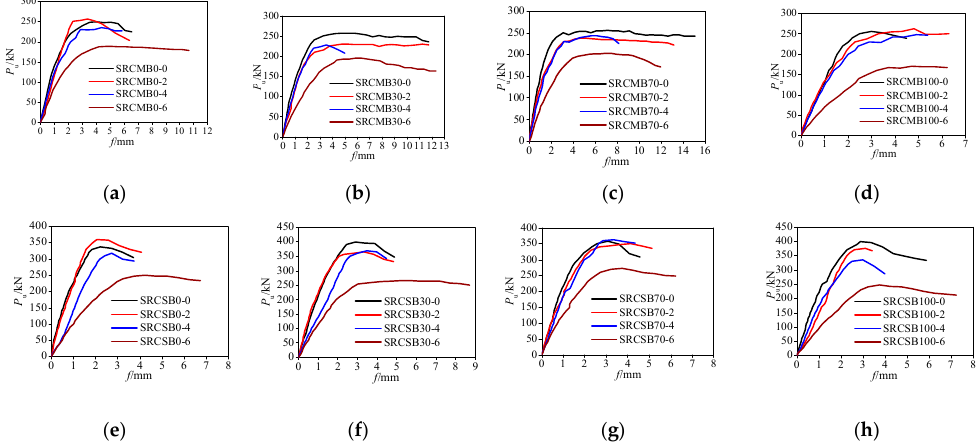
Figure 11. Load-deflection curves of SRRAC beams. ( a ) λ = 2.0, r = 0%; ( b ) λ = 2.0, r = 30%; ( c ) λ = 2.0, r = 70%; ( d ) λ = 2.0, r = 100%; ( e ) λ = 1.2, r = 0%; ( f ) λ = 1.2, r = 30%; ( g ) λ = 1.2, r = 70%; ( h ) λ = 1.2, r = 100%.